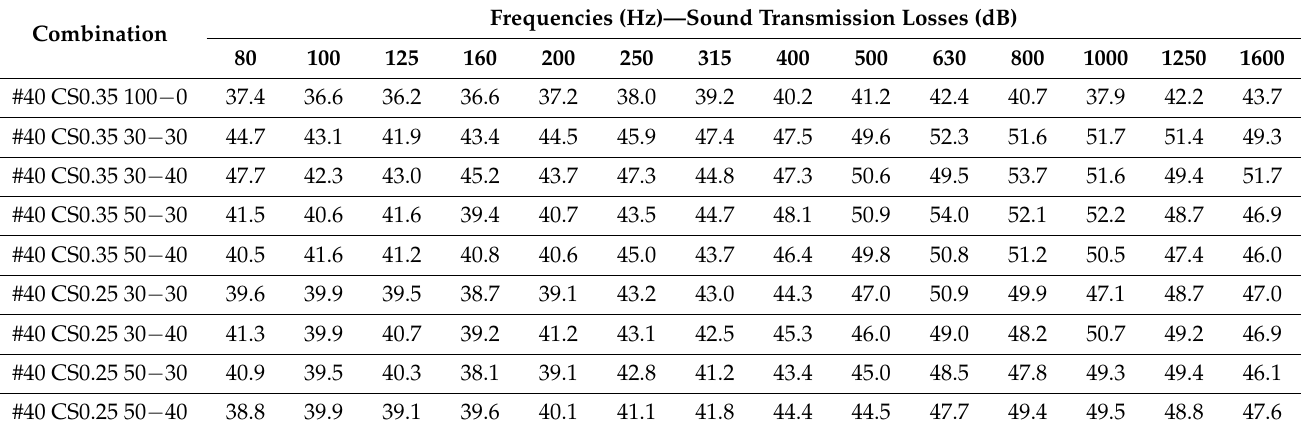
Table 10. Sound transmission losses of different